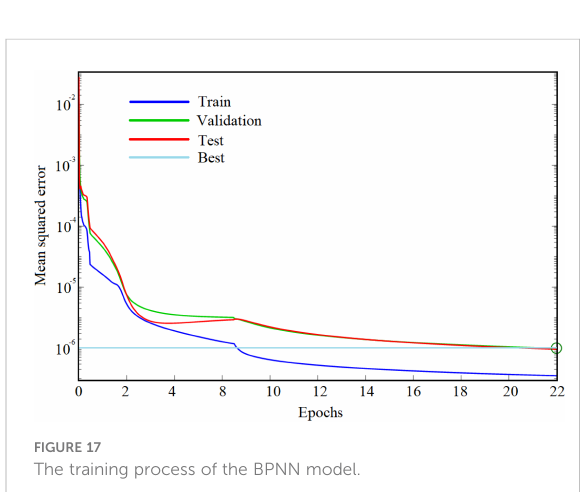
FIGURE 17 The training process of the BPNN model.